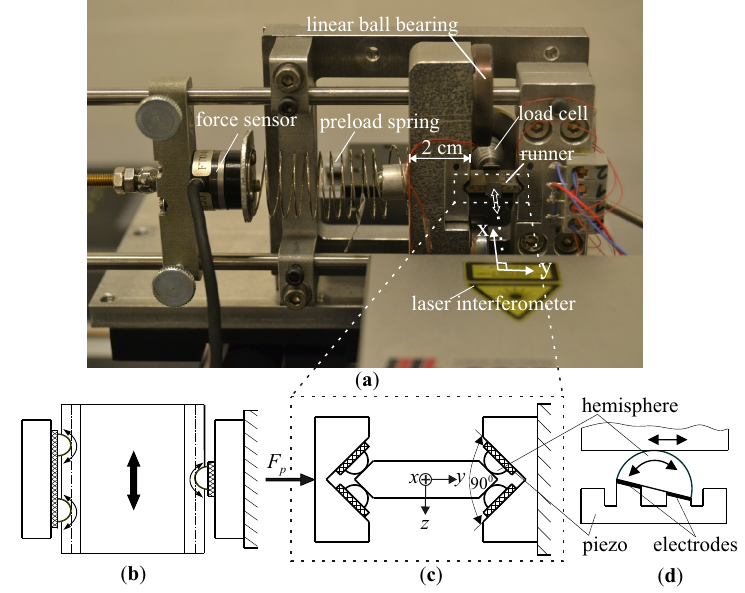
Figure 2. Setup of the experimental test stand: ( a ) photo of the real setup; ( b ) CAD-based schematic top-view (CAD—Computer Aided Design); ( c ) CAD-based schematic front-view; ( d ) CAD-based schematic view of the piezo actuators